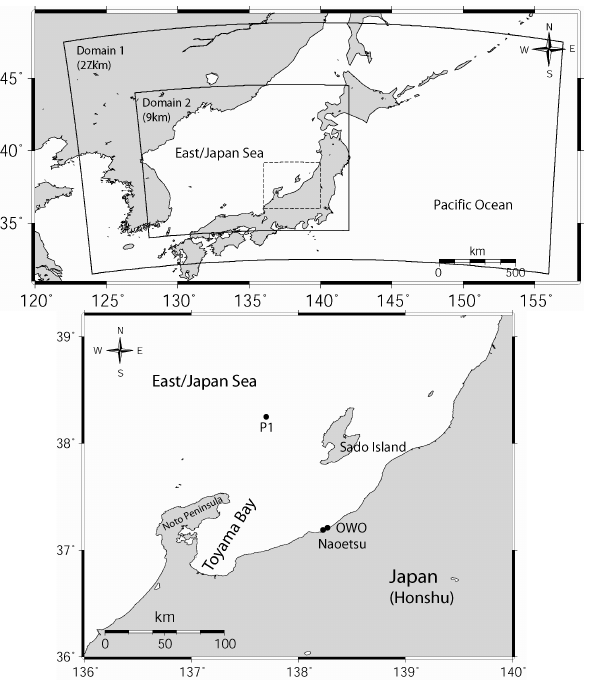
Fig. 3. Computational domains of the mesoscale model for the event of December 2003 and locations of OWO of Kyoto University, Naoetsu Harbour, and P1 (at a point off Sado Island).